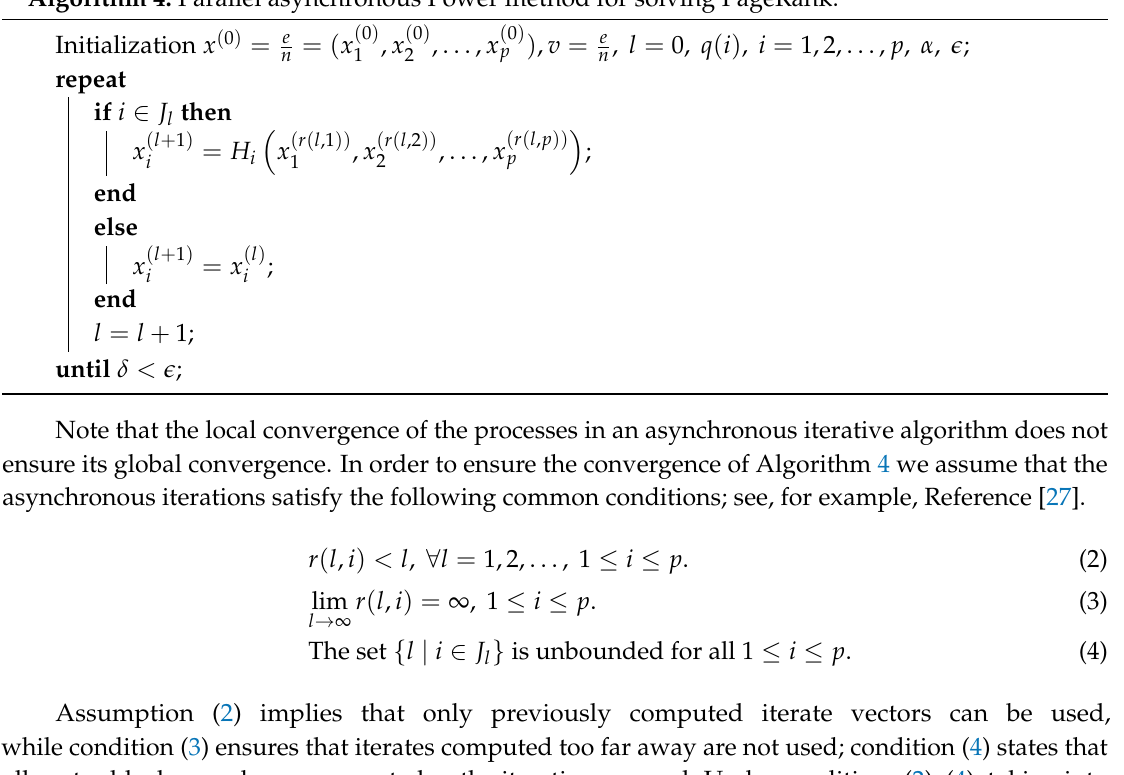
Algorithm 4: Parallel asynchronous Power method for solving